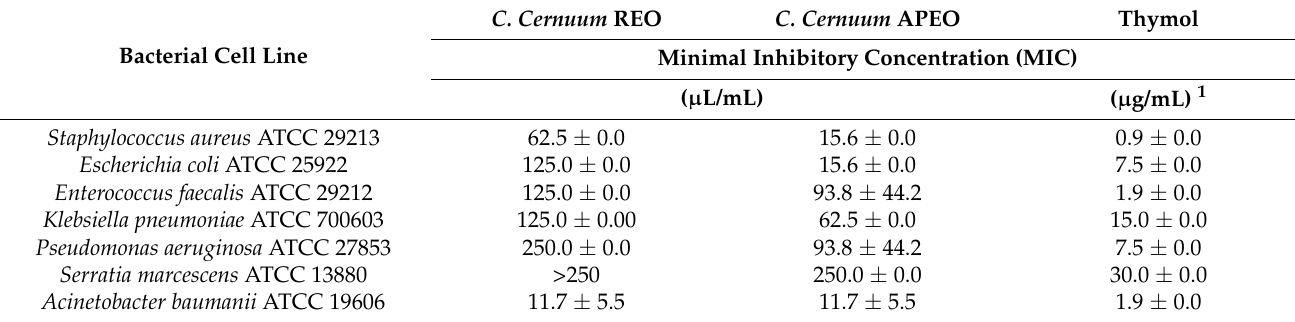
Bacterial Cell Line